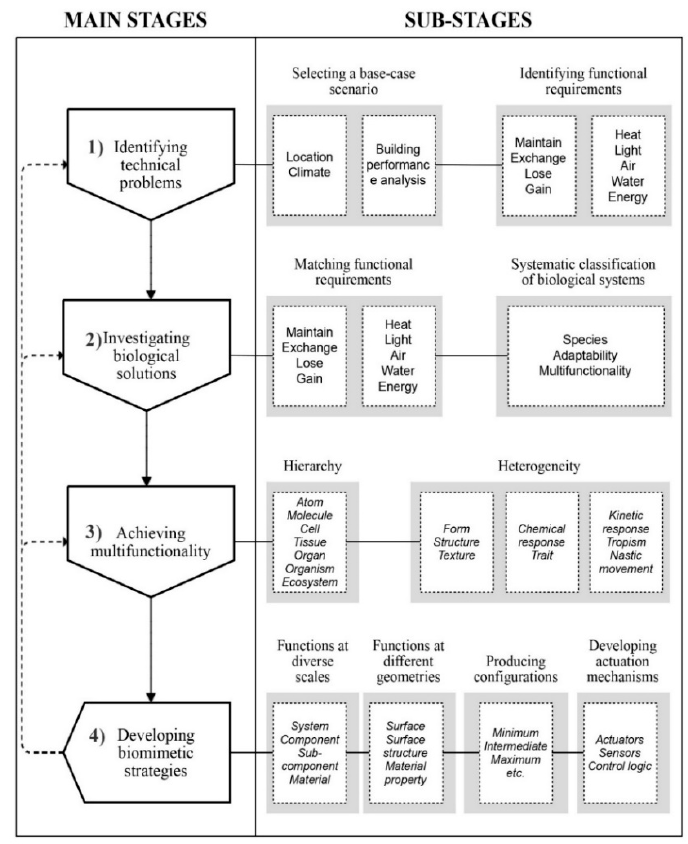
Figure 12. The multi-biomechanism approach and its stages. (1) Identifying technical problems, (2) investigating biological solutions, (3) achieving multifunctionality, and (4) developing biomimetic strategies.